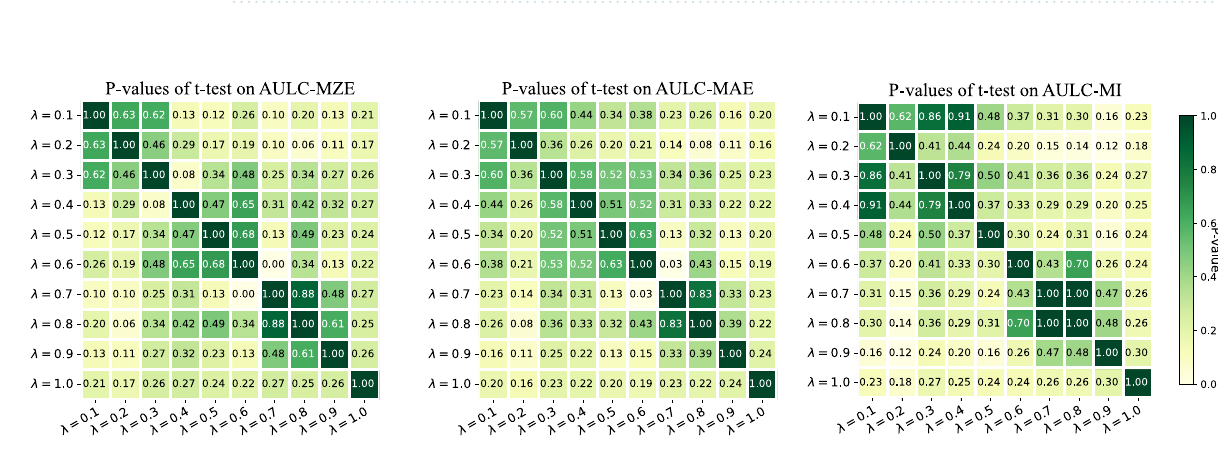
Figure 6. P -values of paired t-tests between the AOCECM methods with different (cid:31) values on the metrics AULC-MZE, AULC-MAE, and AULC-MI, respectively.